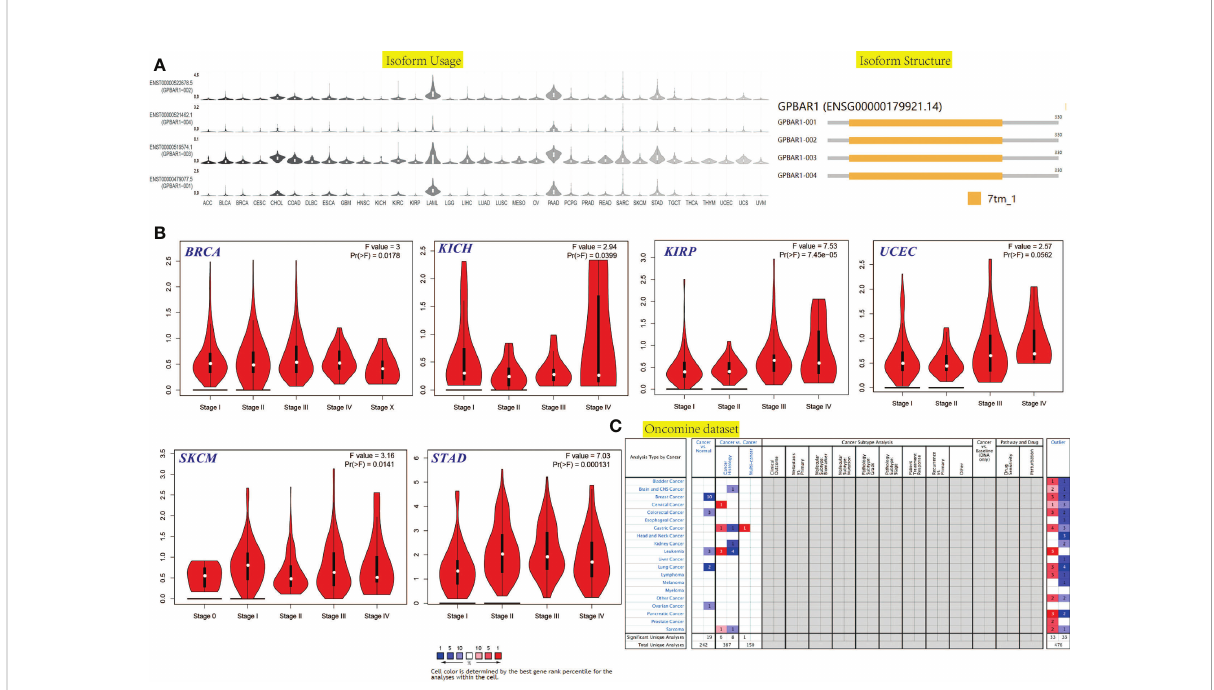
FIGURE 2 The isoform usage and structure, stage-dependent expression, mRNA level in the cancer-wide range of the TGR5 gene in all TCGA tumors. (A) The isoform usage and structure of the TGR5 gene in all TCGA tumors. (B) The stage-dependent expression of the TGR5 gene in BRCA, KICH, KIRP, UCEC, SKCM, and STAD were analyzed by the TCGA data set. (C) The mRNA level in the cancer-wide range of the TGR5 gene in all TCGA tumors from Oncomine data